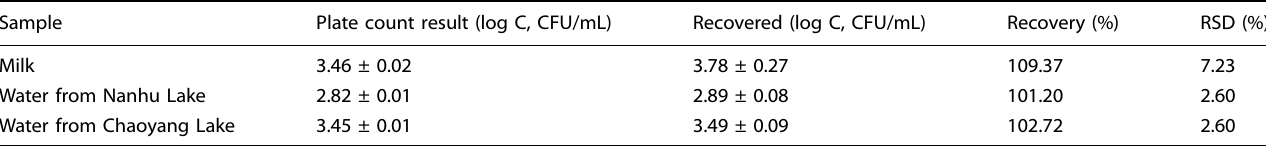
Table 2. Recovery and RSD values of detecting S. typhimurium in real samples x ± s ; n ¼ 3 ð Þ